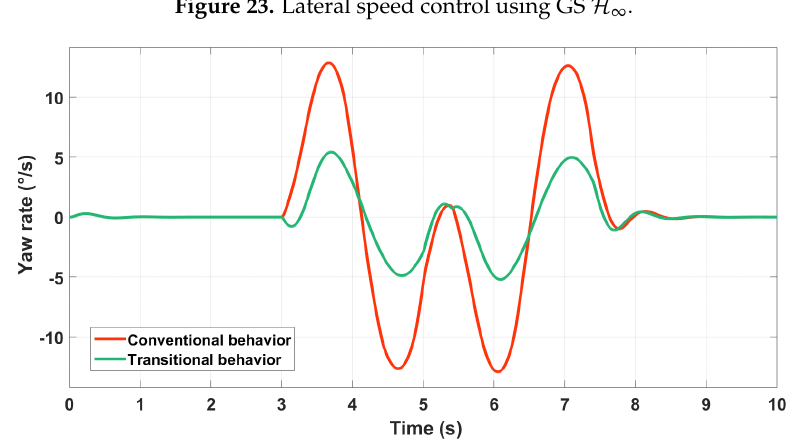
Figure 24. Yaw rate control using GS H ∞